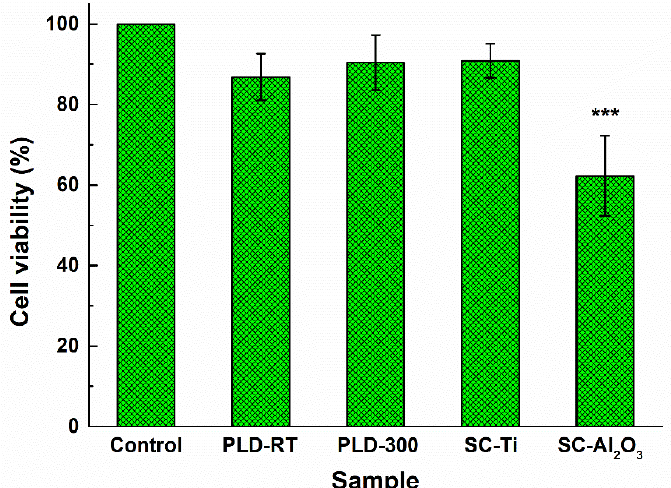
Figure 7. Cell viability in the case of BJ cells grown on the coated samples compared to Control cells grown on glass slides. Statistical analysis was performed using One-way analysis of variance with Dunnett’s multiple comparison test. * p < 0.05, *** p < 0.001.